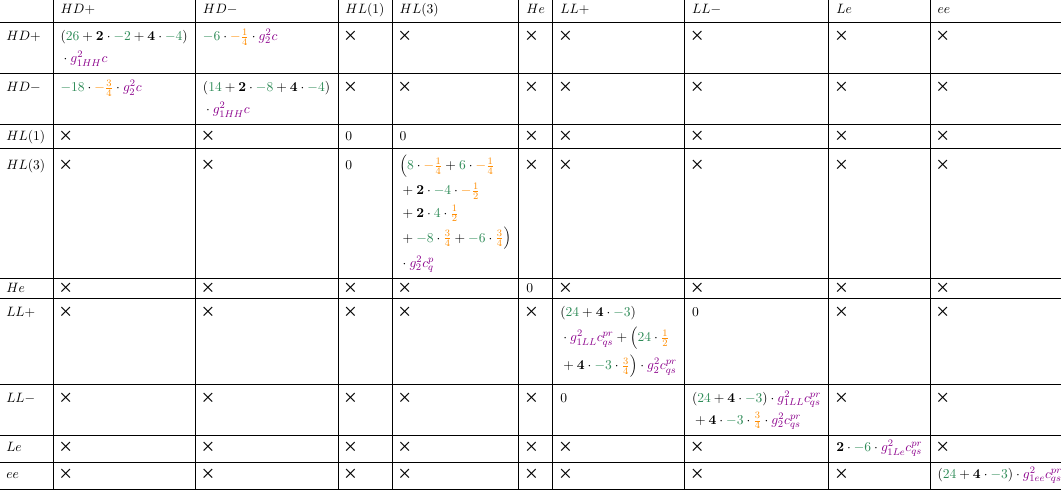
Table 7 . Soft plus collinear gauge pieces. Operators are defined in table 11. Phase space factors, in green, can be found in appendices E.2 and D and are explained in sections 3.1.2 and 3.1.3. Gauge factors, in orange, can be found in tables 2, 13 and 14, and are explained in section 3.2. The flavour factors, in purple, labelled by p, q, r, s indices, can be found in table 3, and are explained in section 3.3. Bold numerical factors are combinatorial: they correspond to several equivalent diagrams for the same process.